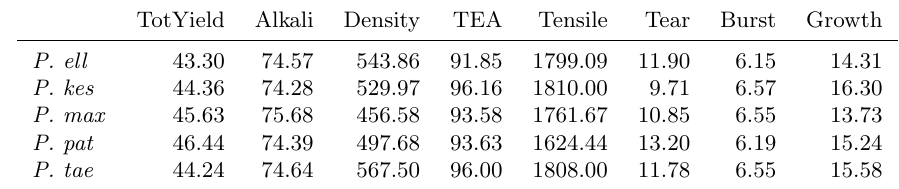
Table 1: Means of five species of pines on eight